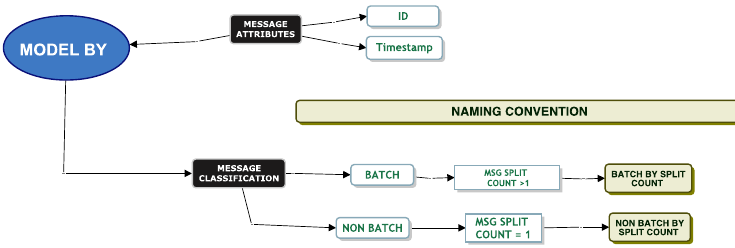
Figure 21. Interdependence by